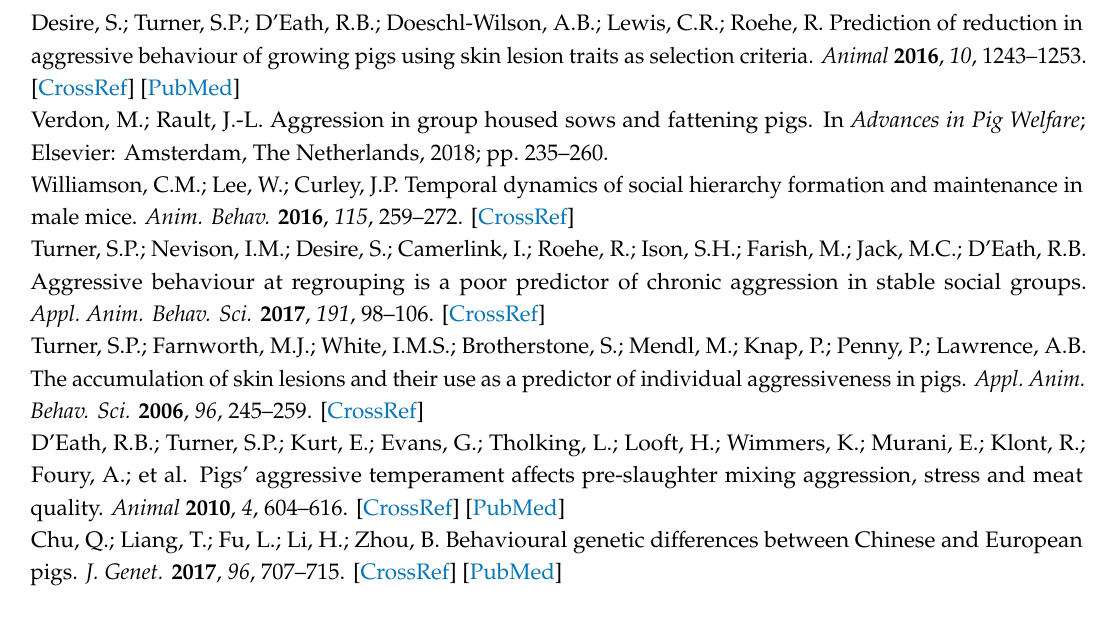
Table S1: Primers for PCR in amplification of the MAOA gene.; Table S2: The numbers of barrows and gilts with di ff erent genotypes of four linked SNPs in the porcine MAOA gene; Table S3: The numbers of barrows and gilts with di ff erent haplotypes in the porcine MAOA gene; Table S4: Change of transcription factor-binding sites before and after the SNP rs321936011 mutation in the promoter region of the porcine MAOA gene. Author Contributions: B.Z. and R.C. designed the study and wrote the protocol. R.C., C.S., X.T., S.G., and X.L. collected the samples and data in pig farm. R.C., Q.C., and S.G. performed the experiments in the laboratory.